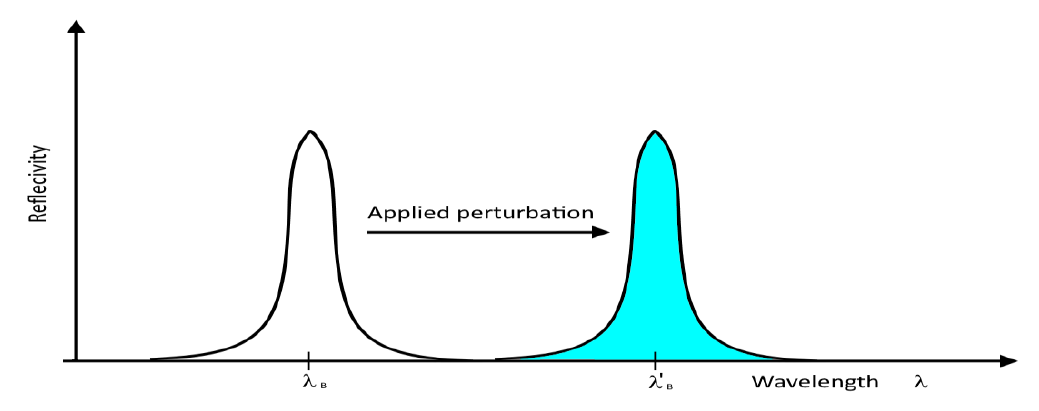
Figure 9. Reflectivity response shift.